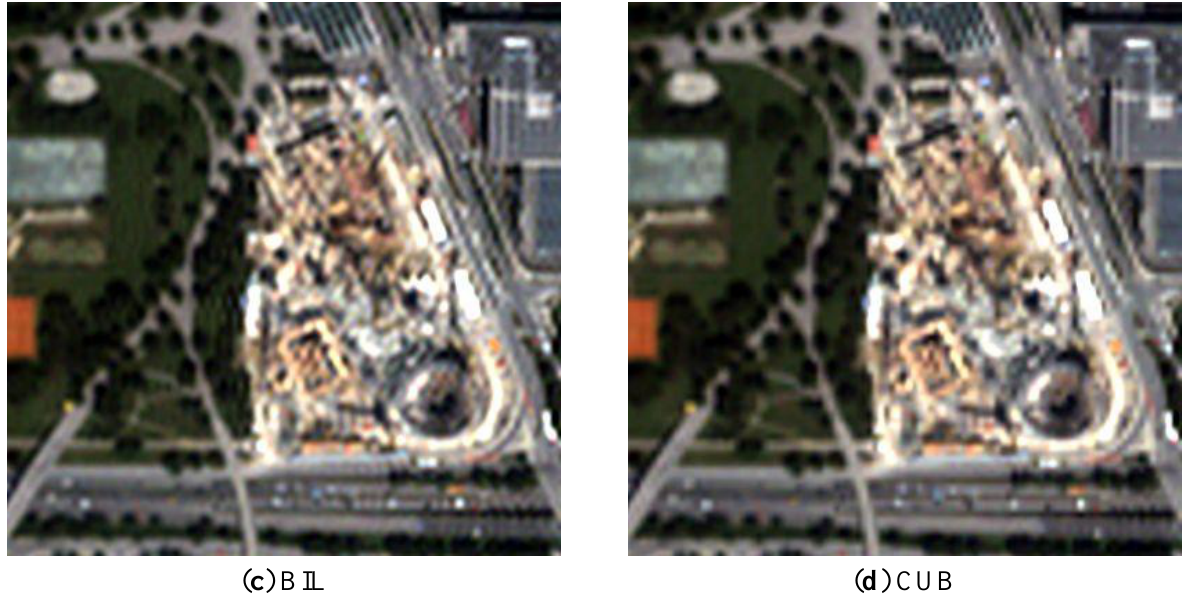
Figure 5. Different interpolation methods: NN ( a ), ZP ( b ), BIL ( c ) and CUB ( d ) for the IKONOS